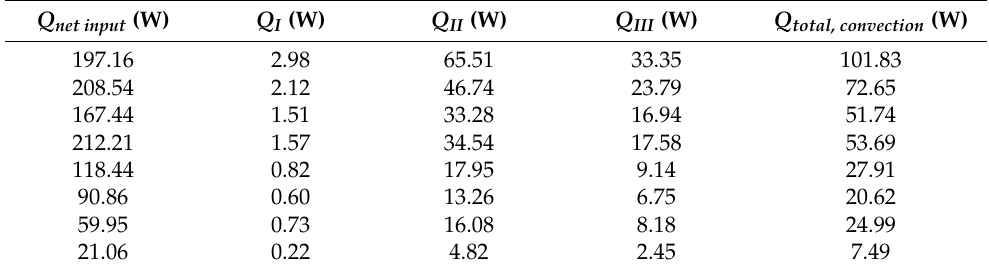
Table 6. Heat transfer due to convection from pipe surface to atmosphere.